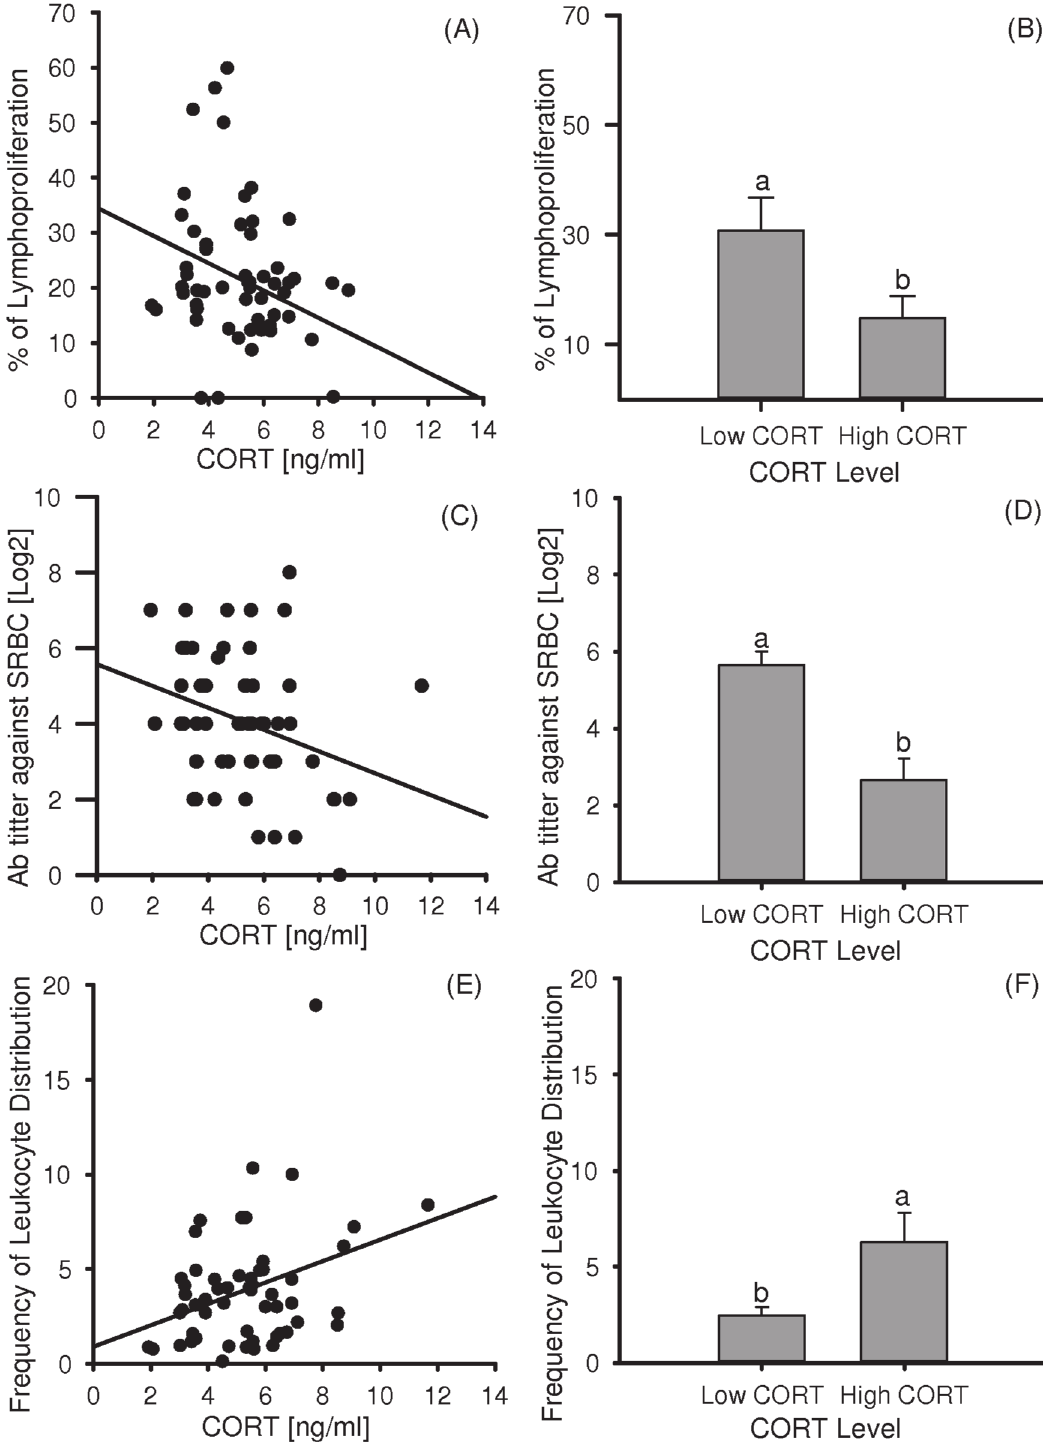
Fig 3. Immune effector analysis in divergent Low and High CORT groups. Correlation plots between CORT and lymphoproliferative response to PHA-P, antibody response against SRBC and FLD are presented in panels A, C and E. Effect of the aggrupation dependent on the basal levels of CORT on immune effectors is shown in panels B (lymphoproliferative response to PHA-P), D (antibody response against SRBC) and F (FLD). Data are means (number inside bars) ± SE. Number of birds per group = 10. Different letters indicate significant ( p < 0.05) differences between groups. FLD number was calculated using the following formula: FLD = number of granulocytes/(number of lymphocytes + number of monocytes).